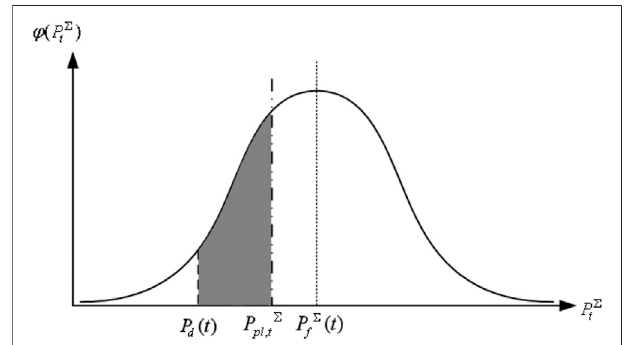
FIGURE 1 | Probability density distribution of the total output of the renewable energy during the period t